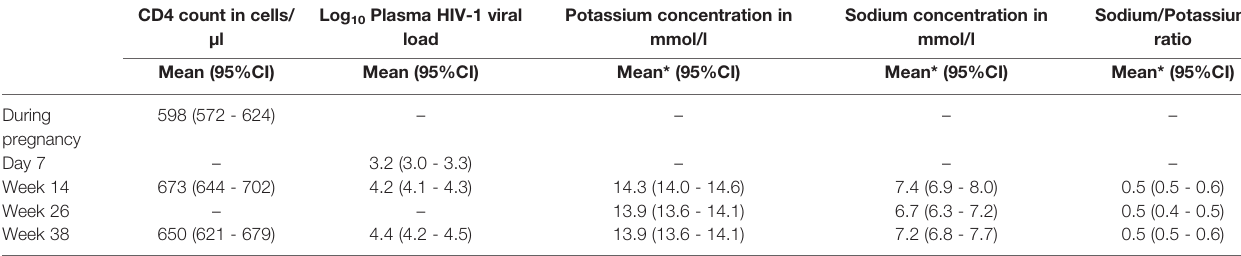
TABLE 2 | Time effect on systemic HIV and indicators of subclinical mastitis (SCM).